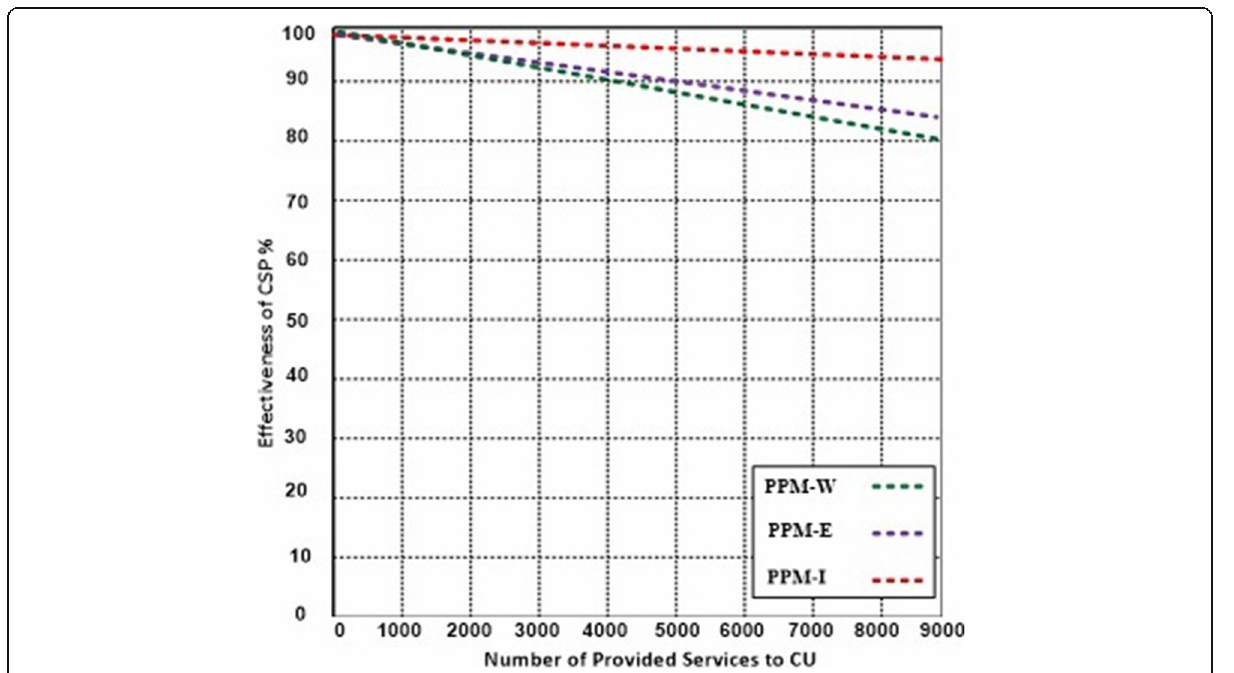
Fig. 7 Effectiveness of CSP VS relatively smaller number of services to Cloud Users